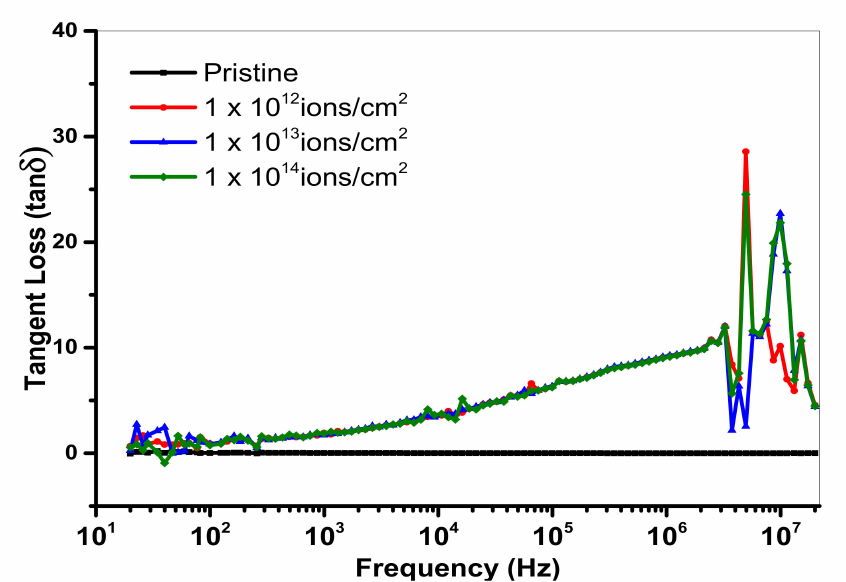
Figure 12. Variation of energy loss of pristine and Cu-ion-implanted samples.